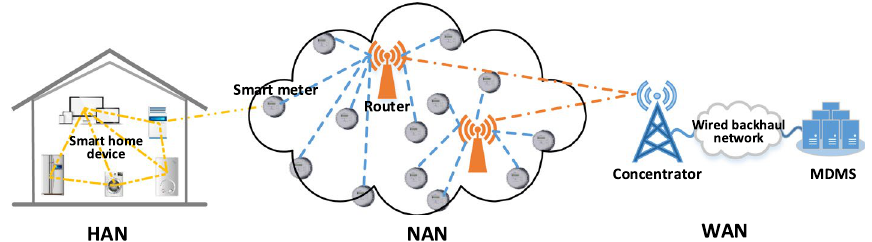
Fig. 1 Smart grid communication network with three representative